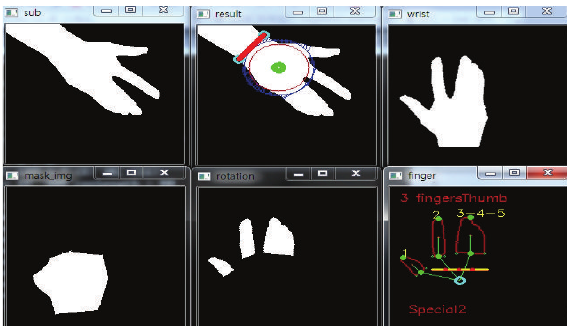
Figure 16: The recognition of the hand gesture 4.